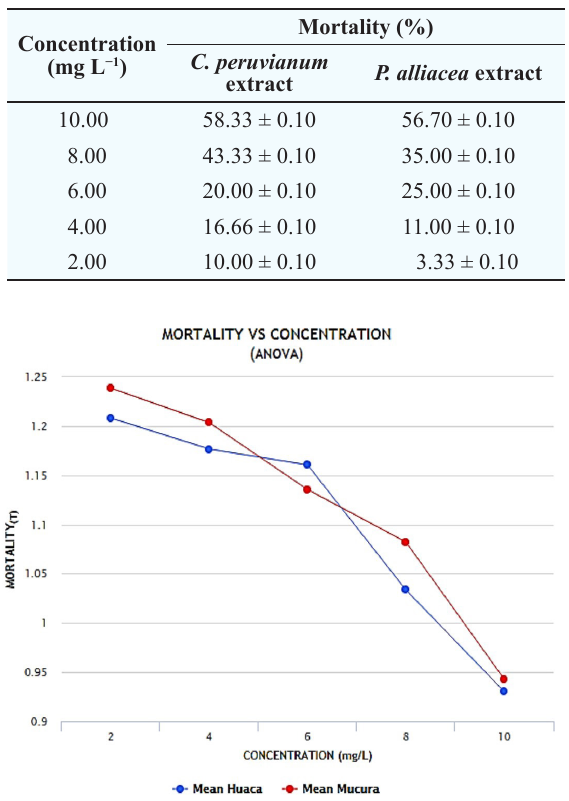
Figure 1. Mortality curve for Musca domestica larvae, where Mortality indicates the percentage of mortality transformed (T) according to Zar (1996), using the data presented in Table 3 versus concentration of C. peruvianum (huaca) and P. alliacea (mucura)